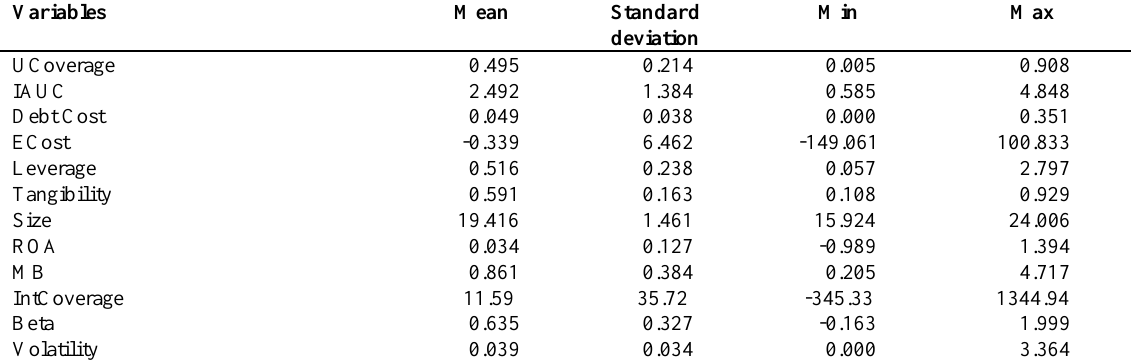
Table 2: Basic statistic